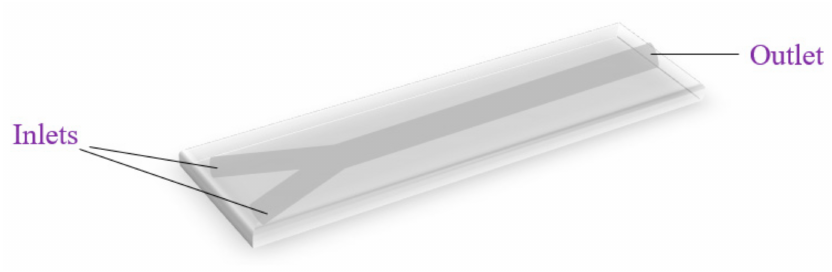
Figure 4. Schematic representation of a typical Y-type